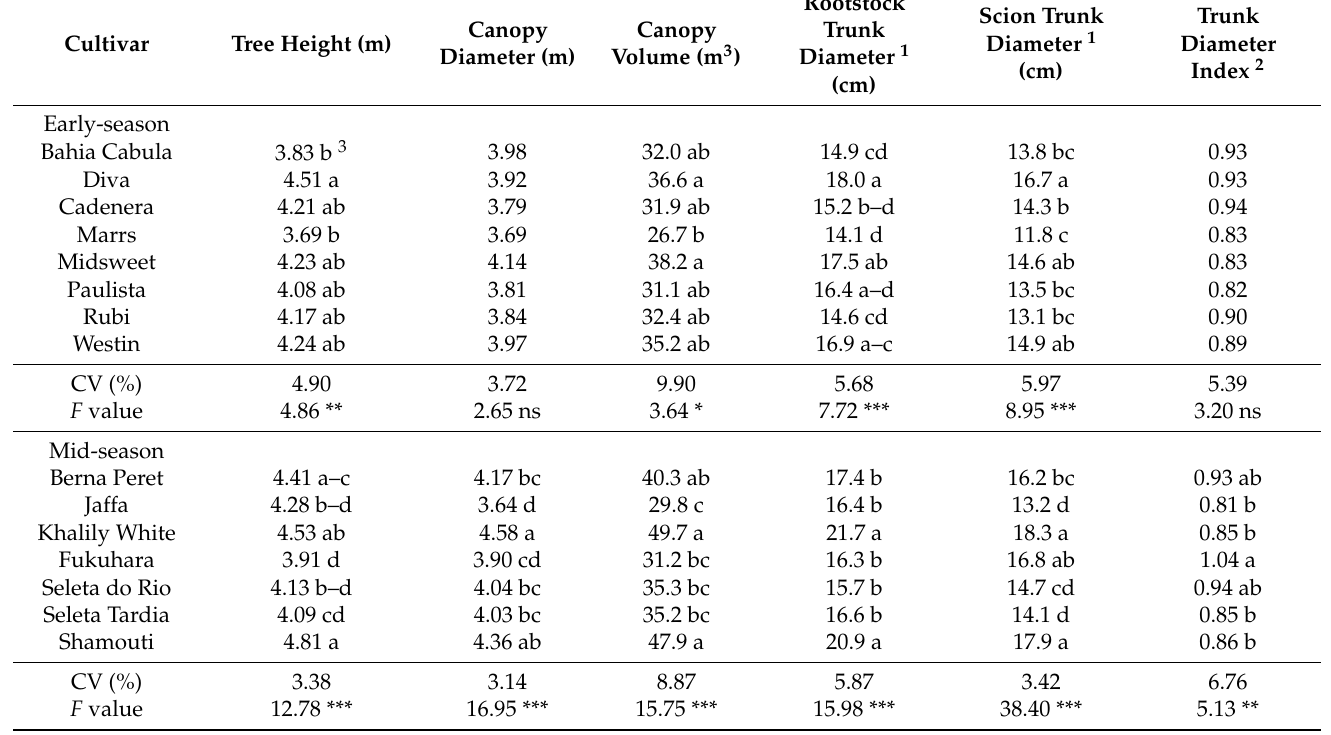
Table 2. Tree size of 15 early-season and mid-season sweet orange cultivars evaluated in 2019 in Guairaç á , Paran á ,